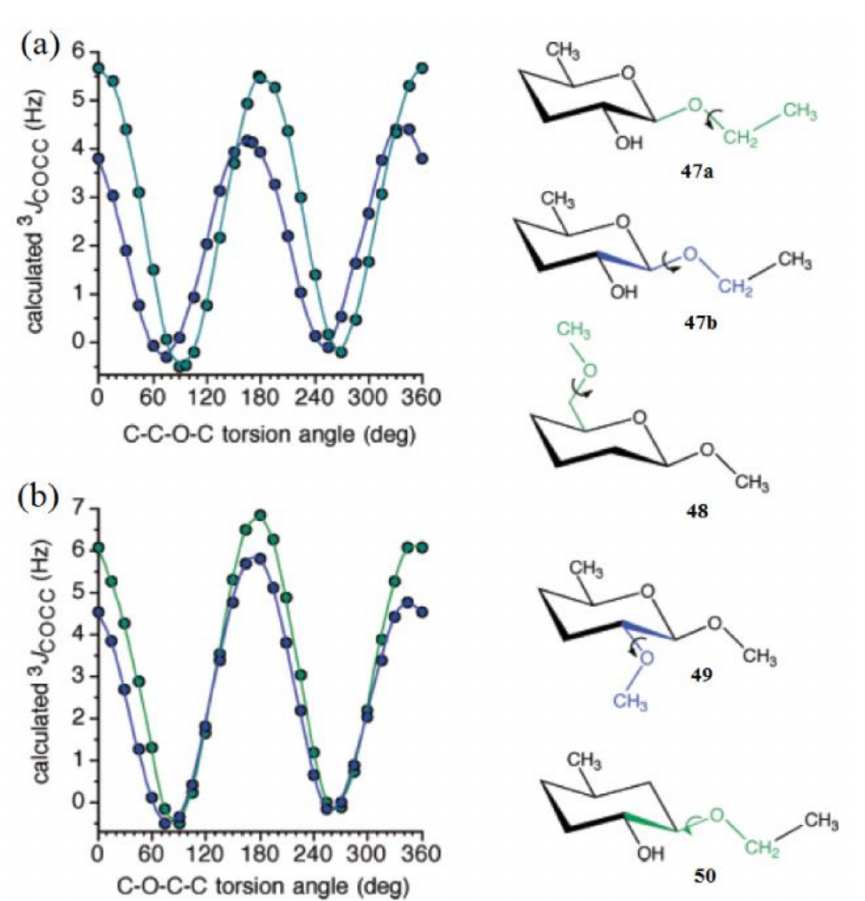
Figure 25. ( a )—Calculated 3 J COCC values in compounds 47a (green symbols) and 47b (blue symbols) as a function of the central C–O bond torsion. Pertinent coupling pathways are highlighted in green in 47a and blue in 47b . ( b )—Calculated 3 J COCC values in compounds 48 (green symbols) and 49 (blue symbols) as a function of the central C − O bond torsion. The corresponding coupling pathways are highlighted in green in 48 and in blue in 49 . Reproduced with minor editing privilege from Zhao et al. [133] with the permission of the American Chemical